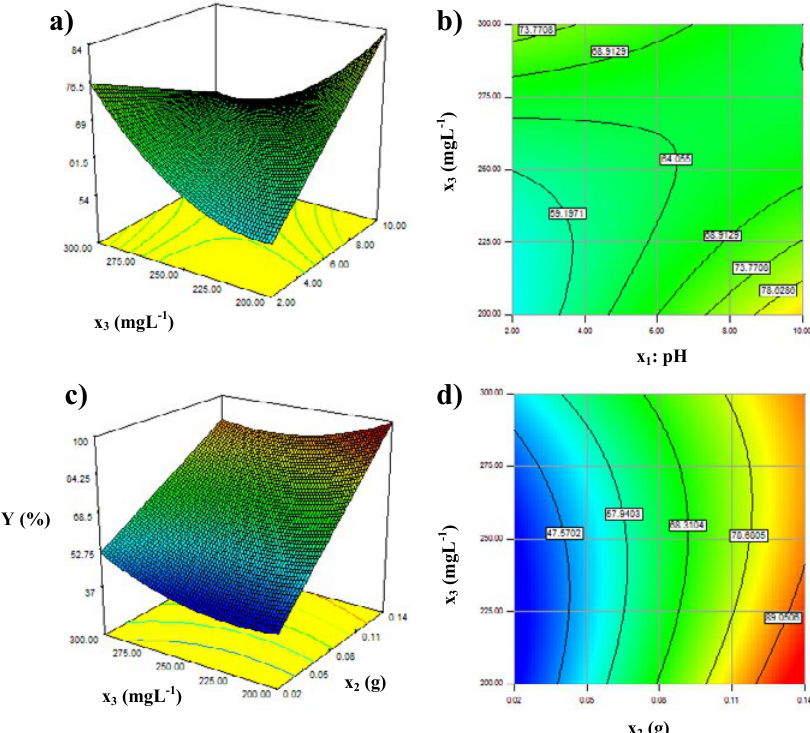
Fig. 14. Response surfaces and contour plots of central composite design: (a, b) x 1 -x 3 , (c, d) x 2 -x 3 .